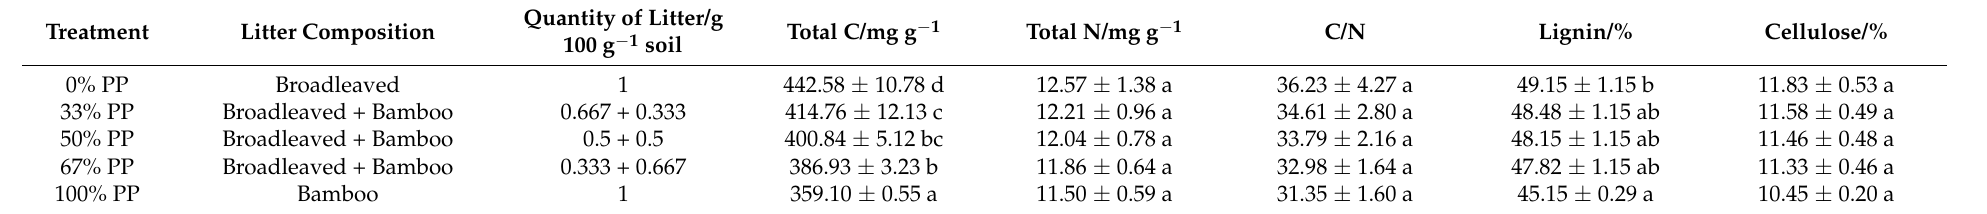
Table 1. Litter C, N and C/N ratio of different leaf litter